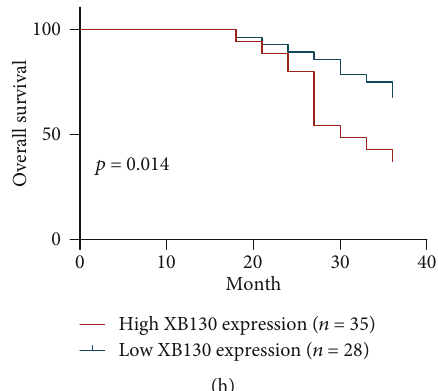
Figure 1: Expression of HBx and XB130 in liver cancer tissues and the matched adjacent normal tissues. (a) Di ff erentially expressed mRNAs in liver cancer tissues and adjacent normal tissues screened out using microarray-based analyses. (b, c) Expression of HBx and XB130 in liver cancer and adjacent tissues examined by RT-qPCR. (d, e) Correlation analyses on HBx and XB130 expression with tumor size. (f) HBx and XB130 expression in tissues analyzed by immunohistochemistry. (g, h) Survival analysis on HBx and XB130 expression with prognosis of liver cancer patients. ∗ p < 0 : 05 indicates statistical signi fi